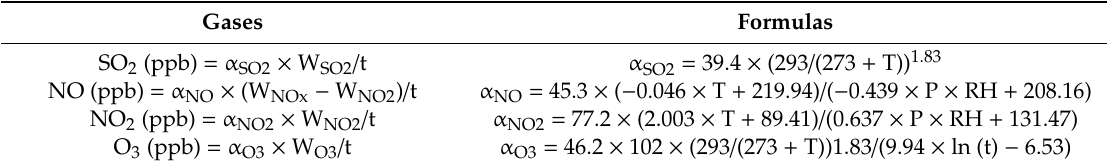
Table 2. Calculation of the gas concentrations in the surface atmosphere [23]. Gases Formulas SO 2 (ppb) = α SO2 × W SO2 /